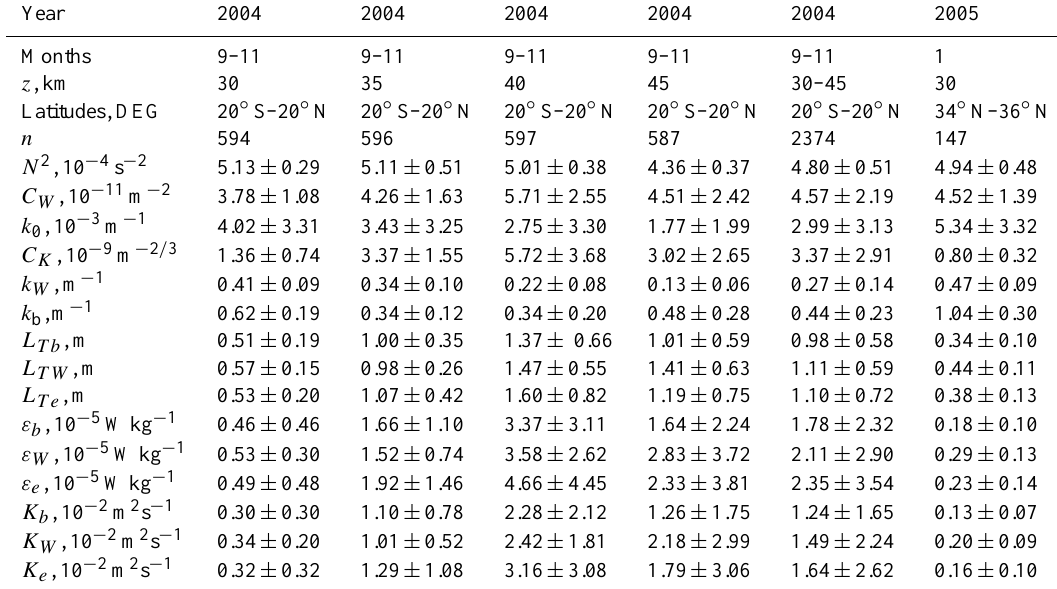
Table 1. Averages and standard deviations of the spectral parameters and turbulence